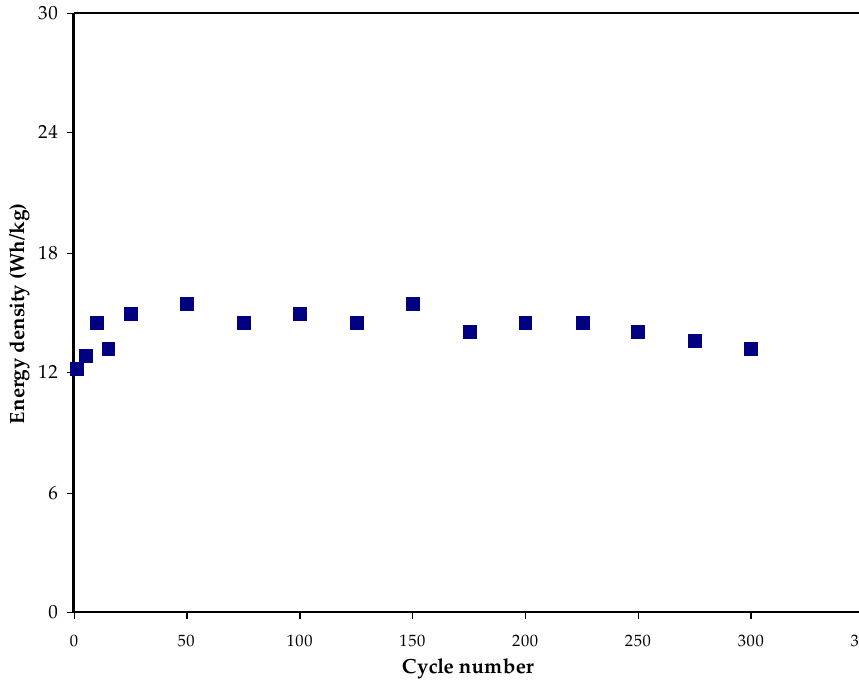
Figure 8. Energy density ( E d ) of the constructed EDLC against cycle number.